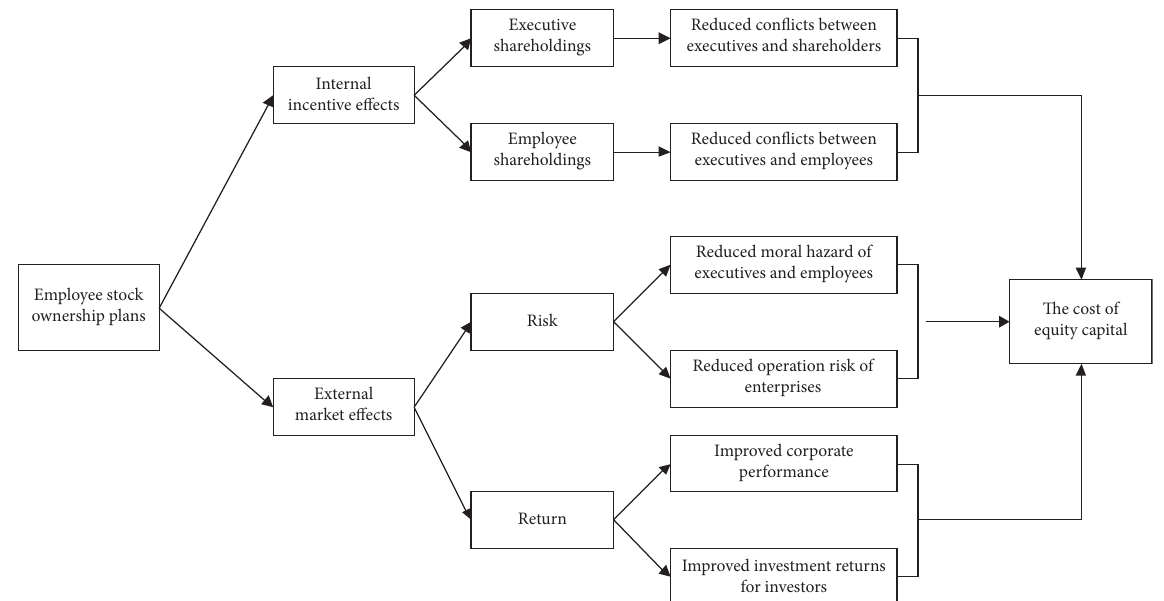
Figure 1: The mechanisms of how ESOP affects the cost of equity